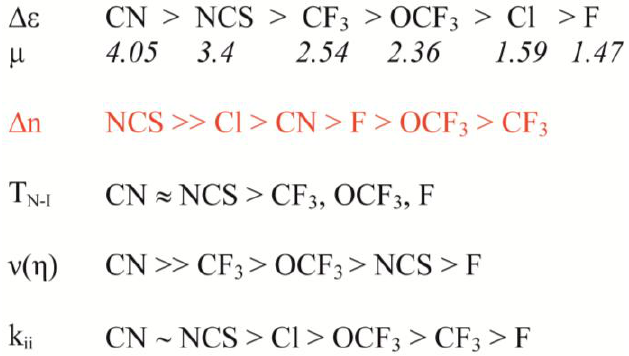
) decrease from left to ii